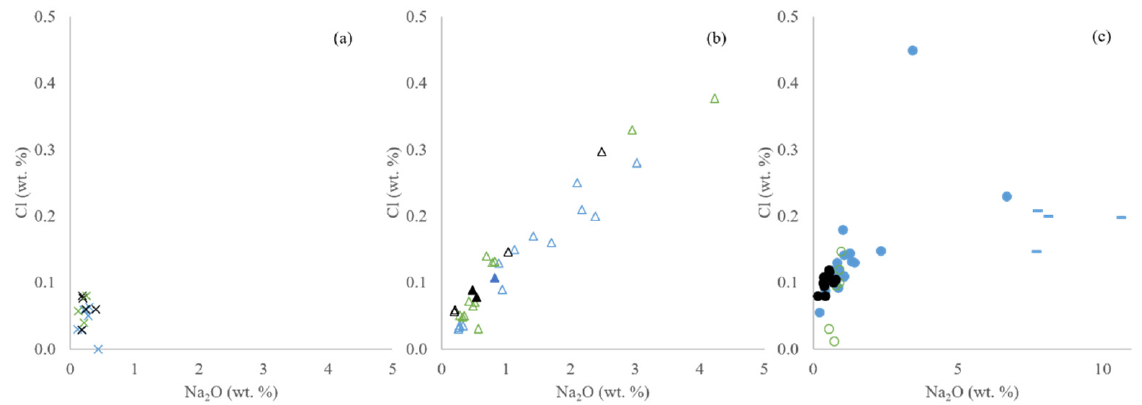
Figure 5. Amounts of Cl compared to Na 2 O, differentiation according to dating: ( a ) medieval glass ( b ) early modern glass I/Renaissance and ( c ) glass of 18th–19th century. Figure ( a ) clearly demonstrates that no NaCl was added to the medieval glass. Additions of NaCl to the glass batch during 16th–17th century can be inferred from Figure ( b ). Finally, NaCl additions were abandoned in younger glasses (as seen in Figure ( c )). The glass dated to the 2nd half of 19th century does not correspond to the dependence of Cl-Na 2 O and Figure ( c ) indicates the usage of a sodium raw material other than NaCl. Symbols: × —medieval ash glass, ∆ —early modern/Renaissance ash glass, ▲ —early modern/Renaissance non-ash glass, ○ —ash glass of 18th–19th century ● —non-ash glass of 18th–19th century and —glass of 2nd half of 19th century. Samples differentiated by colours— green, blue and colourless (the colourless samples are represented by black colour/black symbols). Details concerning the samples are provided in the supplementary file, Table S1.